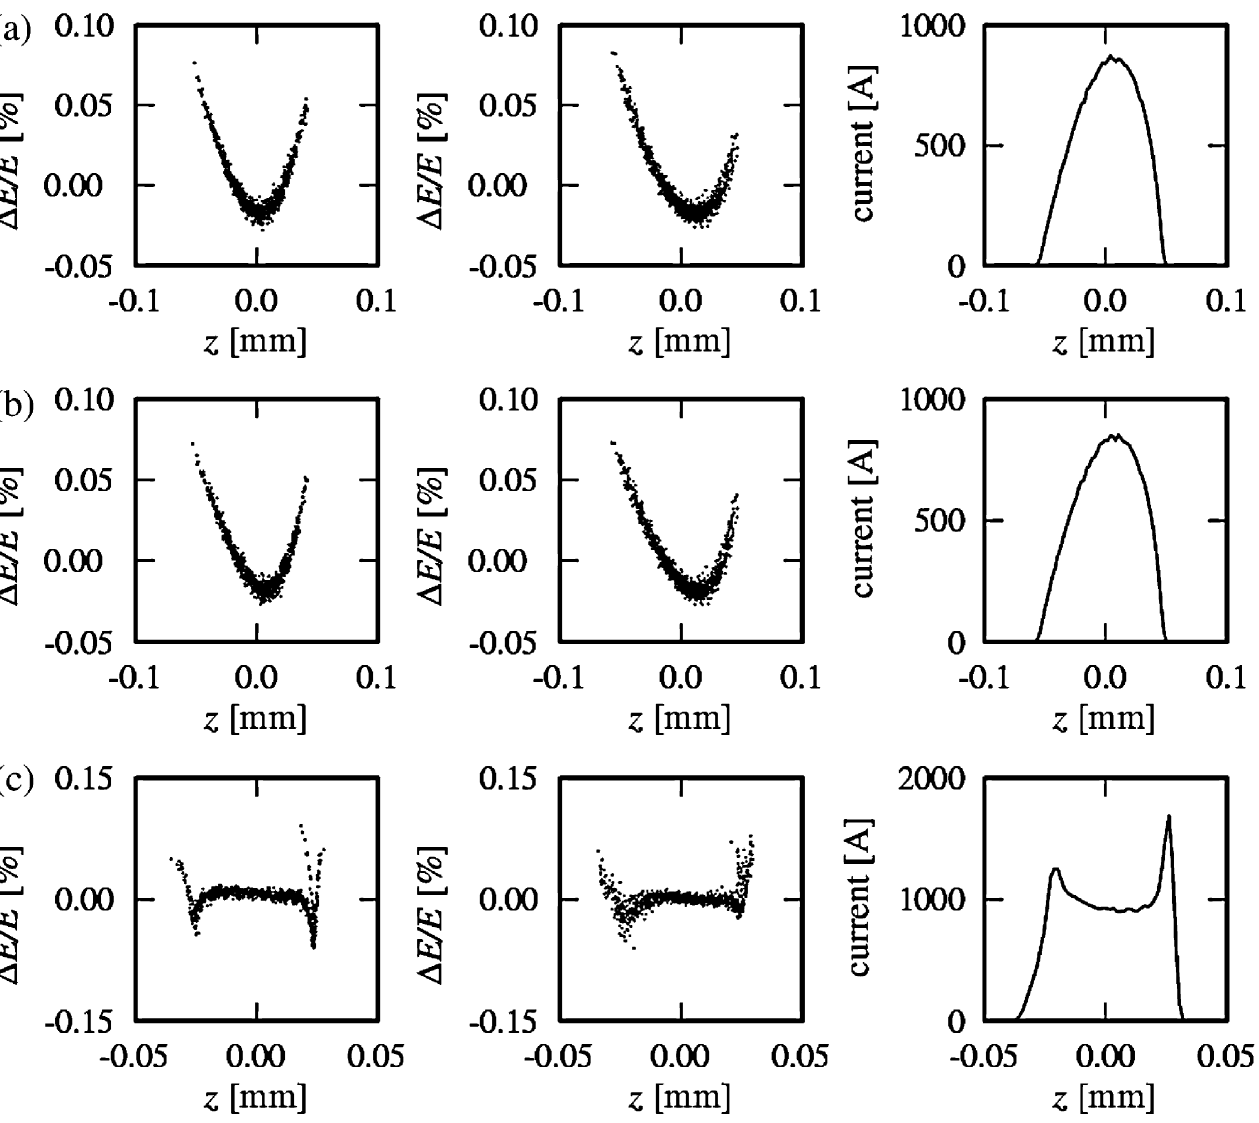
¼ 400 (cid:2) m , and Gaussian energy z